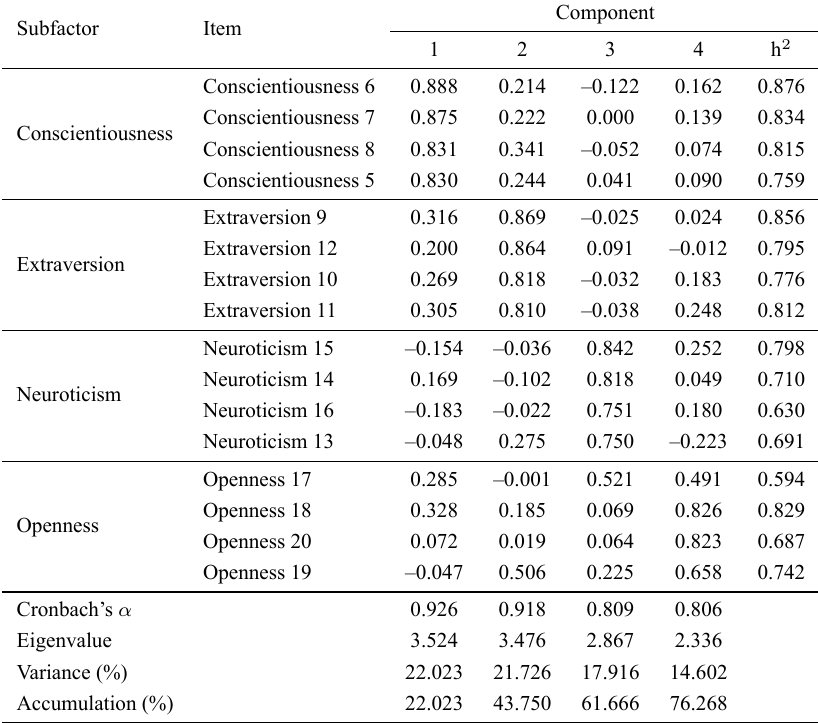
Table 1. Results of exploratory factor analysis for the personality characteristics